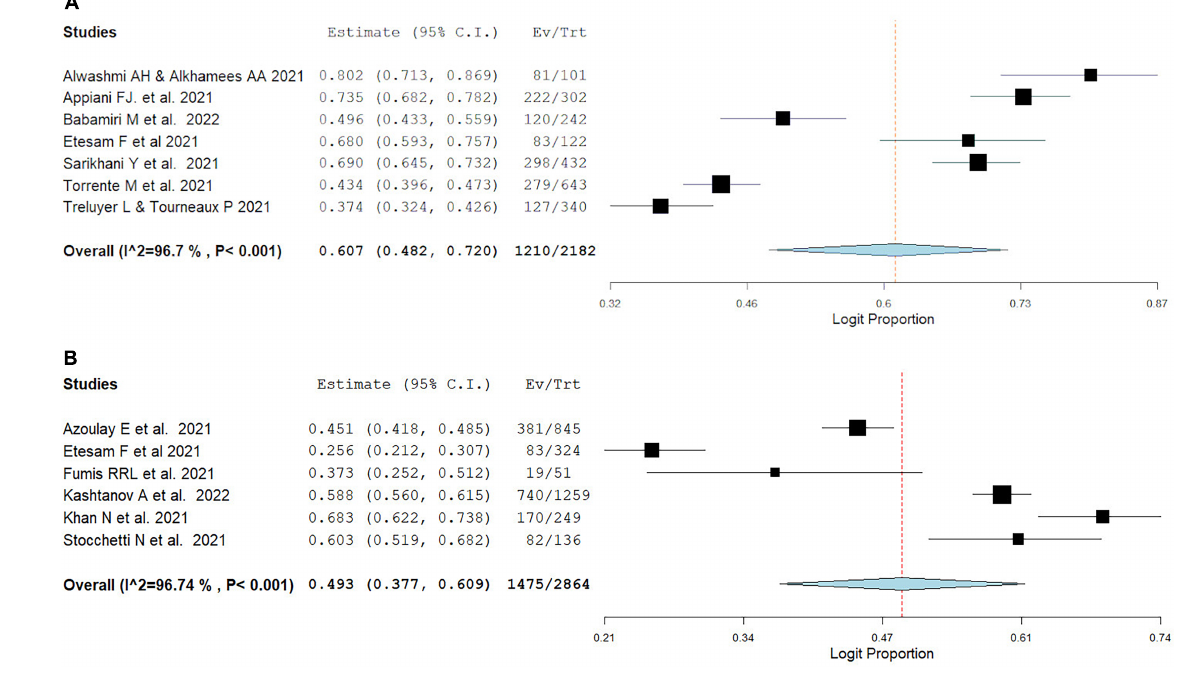
pandemic period was shown to be prevalent in 49.3% (95% CI: 37.7, 60.9%, I 2 = 96.74%) of the